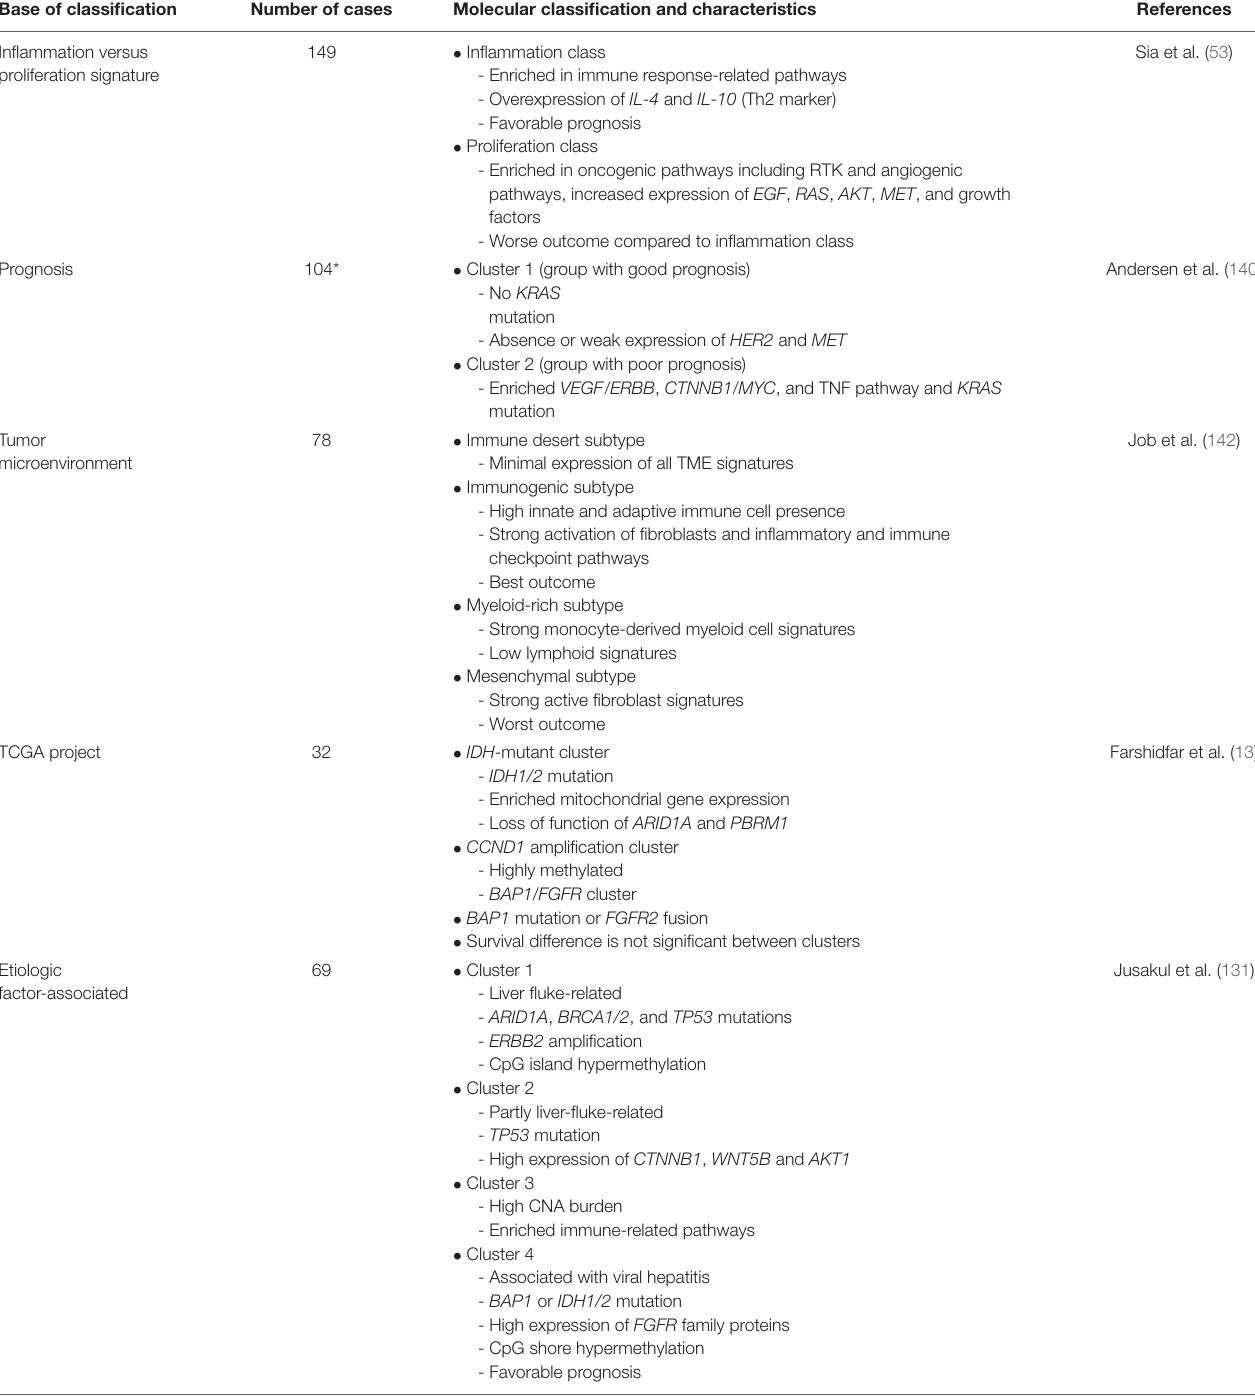
TABLE 3 | Notable classification of intrahepatic cholangiocarcinoma from multi-omics